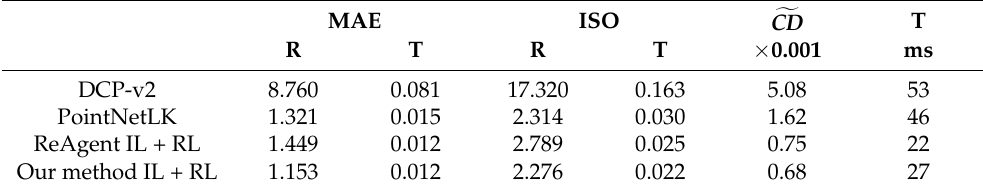
Figure 7. Example of component registration (initial position, step 1, step 7, and the final step). As reported in Table 2, the errors of the new method are consistently smaller than DCP-v2, PointNetLK, and ReAgent. Importantly, the running time of the new method did not have significant changes compared with the running time in the ModelNet40- related experiments. It shows that the methods can be applied to practical applications on real-world data. Table 2. Results on ScanObjectNN and train component. ~ MAE ISO (cid:2159)(cid:2160) T R